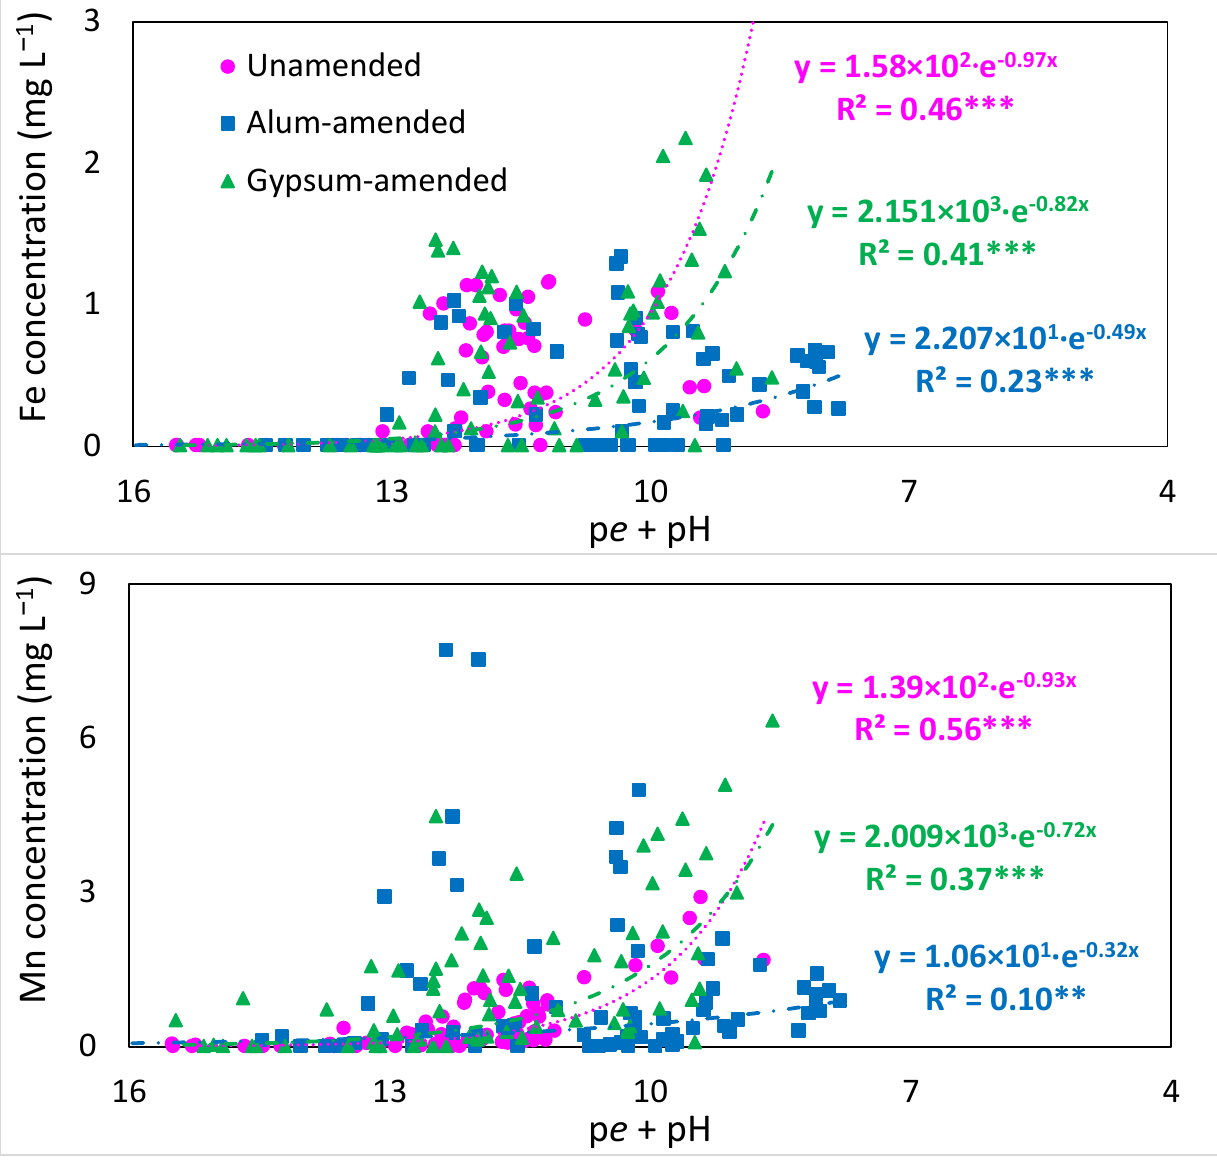
Figure 5. Exponential relationships between pe + pH and porewater concentrations of Fe and Mn in unamended, alum-amended and gypsum-amended monoliths. Note: Values in x-axis are in reverse order. Superscripts *** and ** followed by R 2 indicates significant at p < 0.001 and p < 0.01, respectively (n = 72).